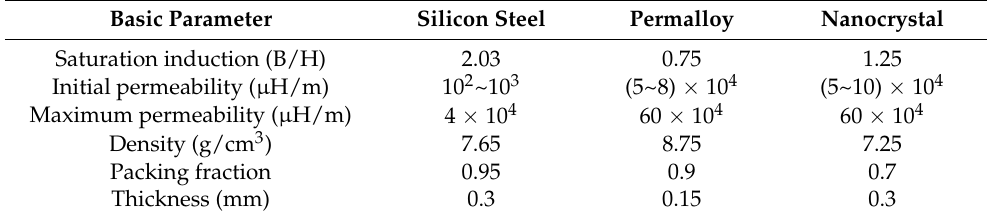
Table 1. Three core materials’ basic